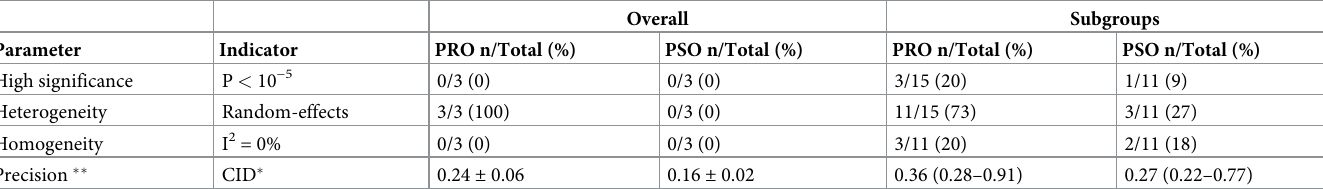
Table 3. Effects of outlier treatment in power sports outcomes.